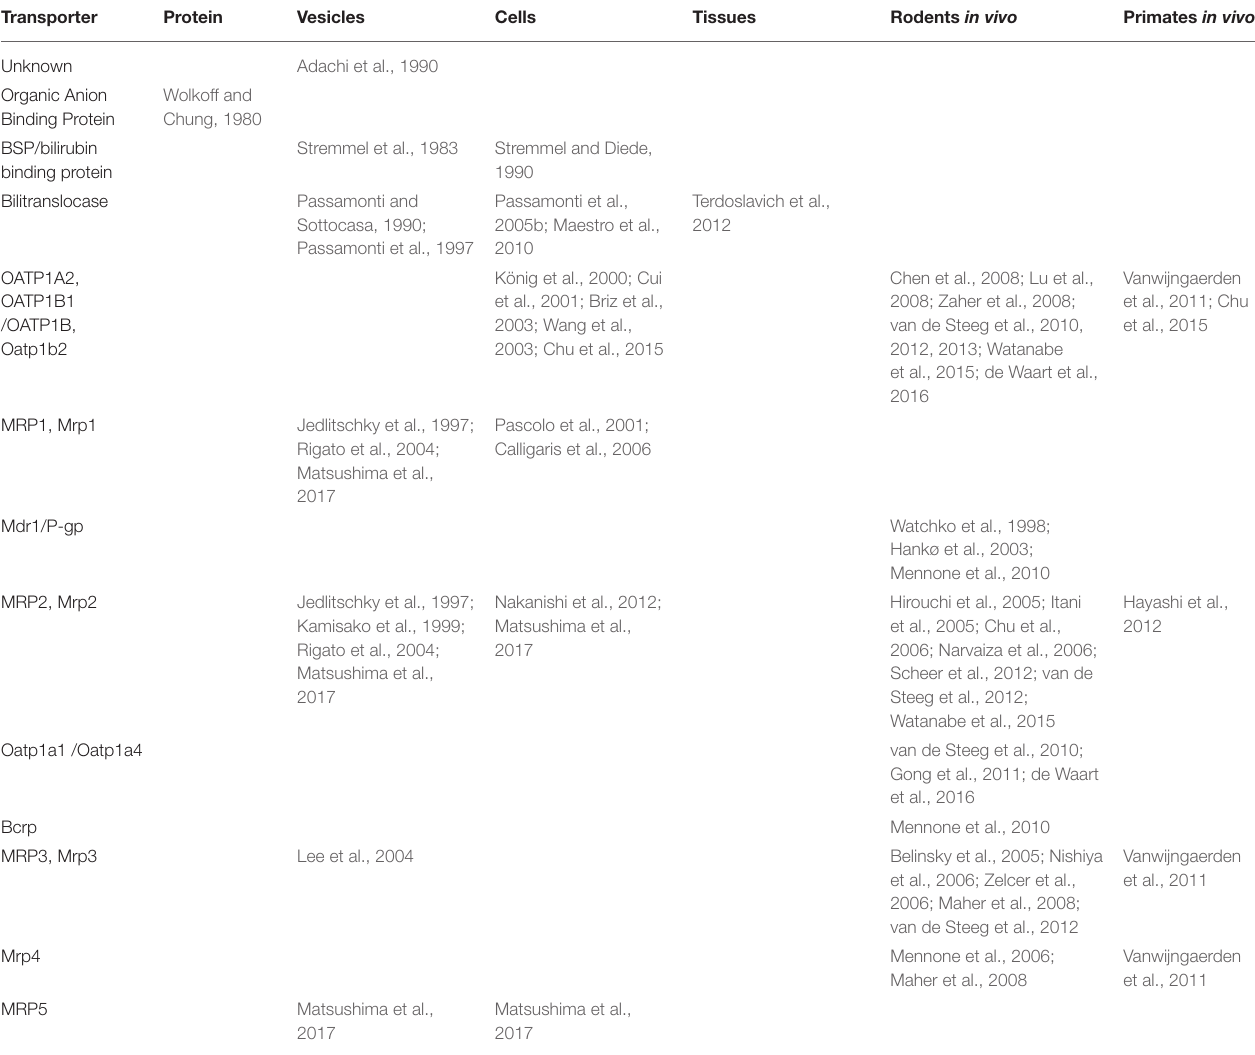
TABLE 5 | Synopsis of the experimental models used to study membrane transporters for bilirubin and its